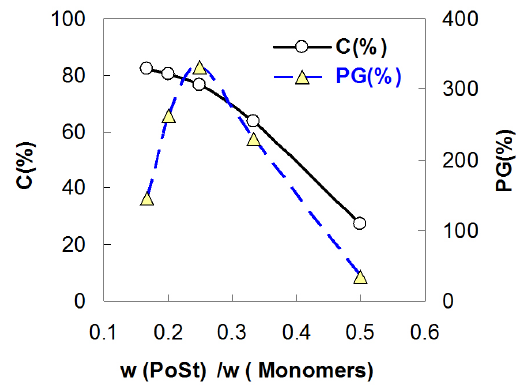
Figure 5. The effect of KPS content on C% and PG% (Cond.: w (BA) / w (MMA) = 1: 1, w(PoSt) / w(Monomers) = 1: 4, Temp: 85°C, Time: 8 hours).